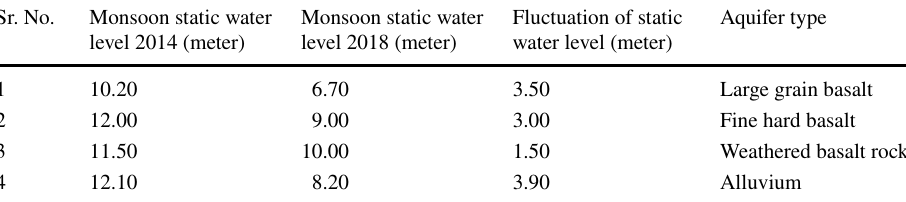
level fluctuation for the year 2014–18